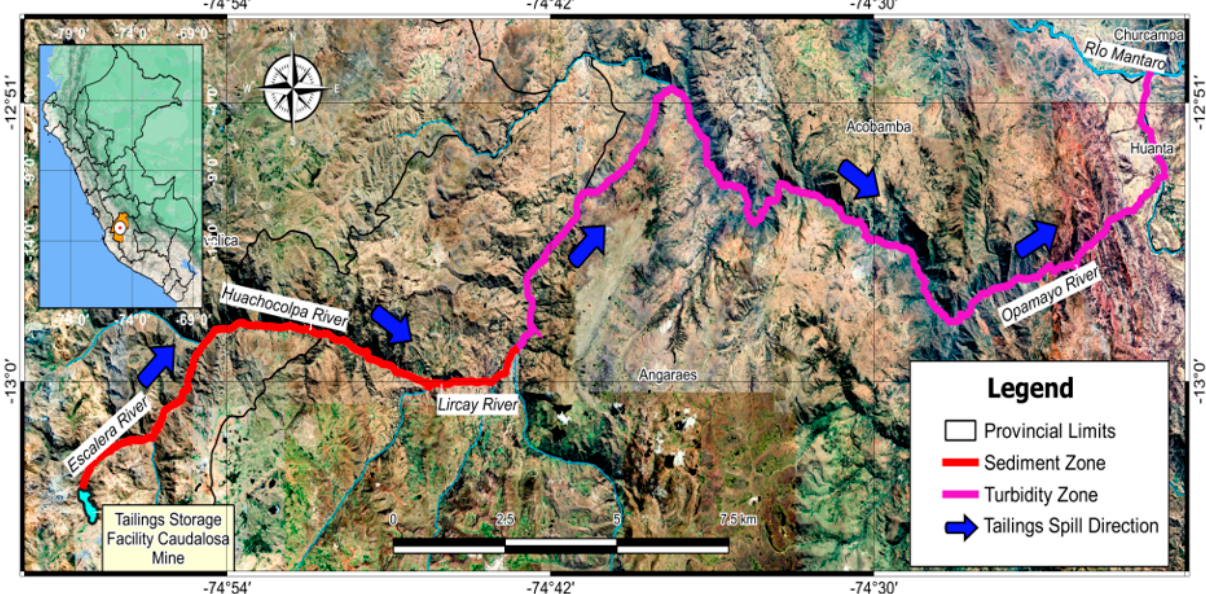
Figure 5. Area affected by tailings spill—Huancavelica Department (Modified from [45]). As observed by residents, the waters of the rivers had a leaden and reddish color, ing a discharge of 57,000 m 3 of mining tailings [45].